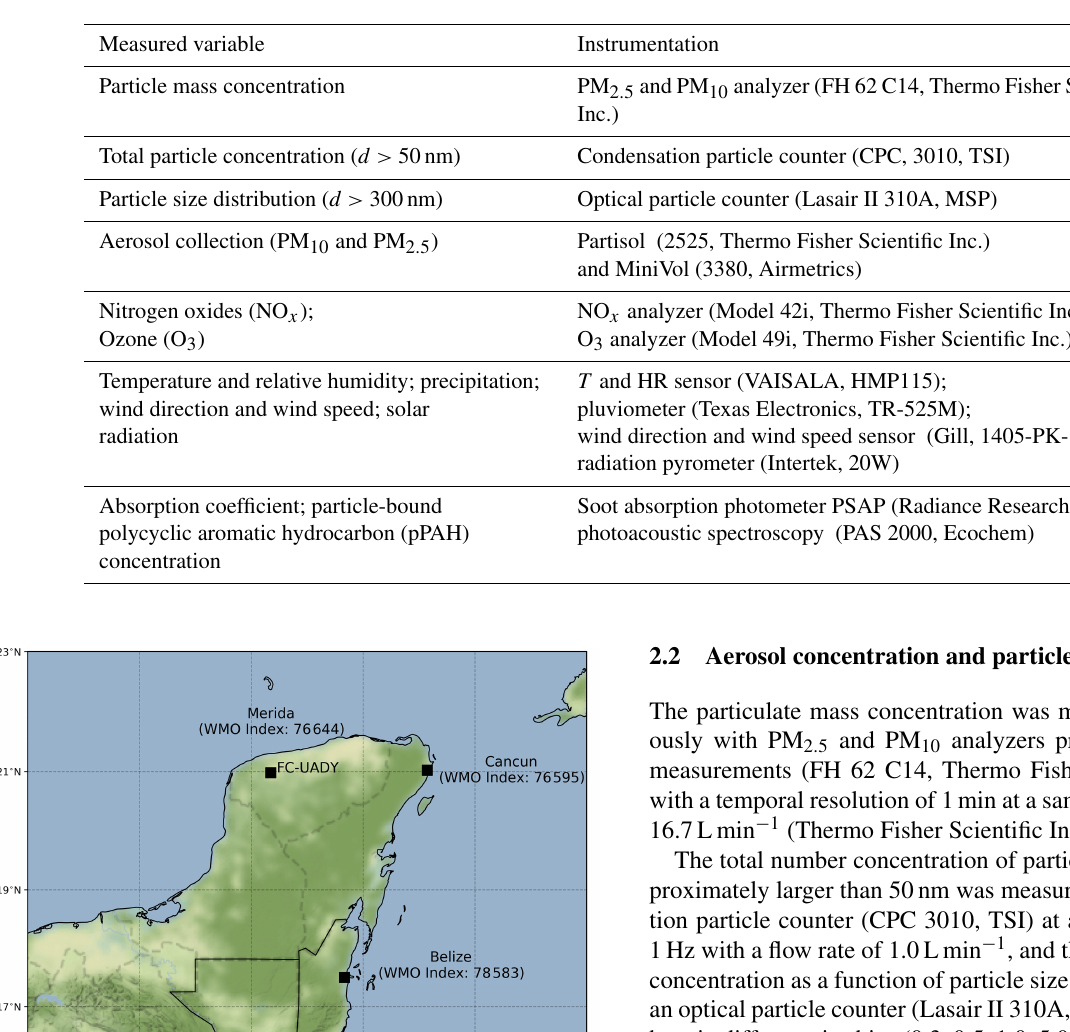
Table 1. Summary of the measured variables and the instrumentation used.